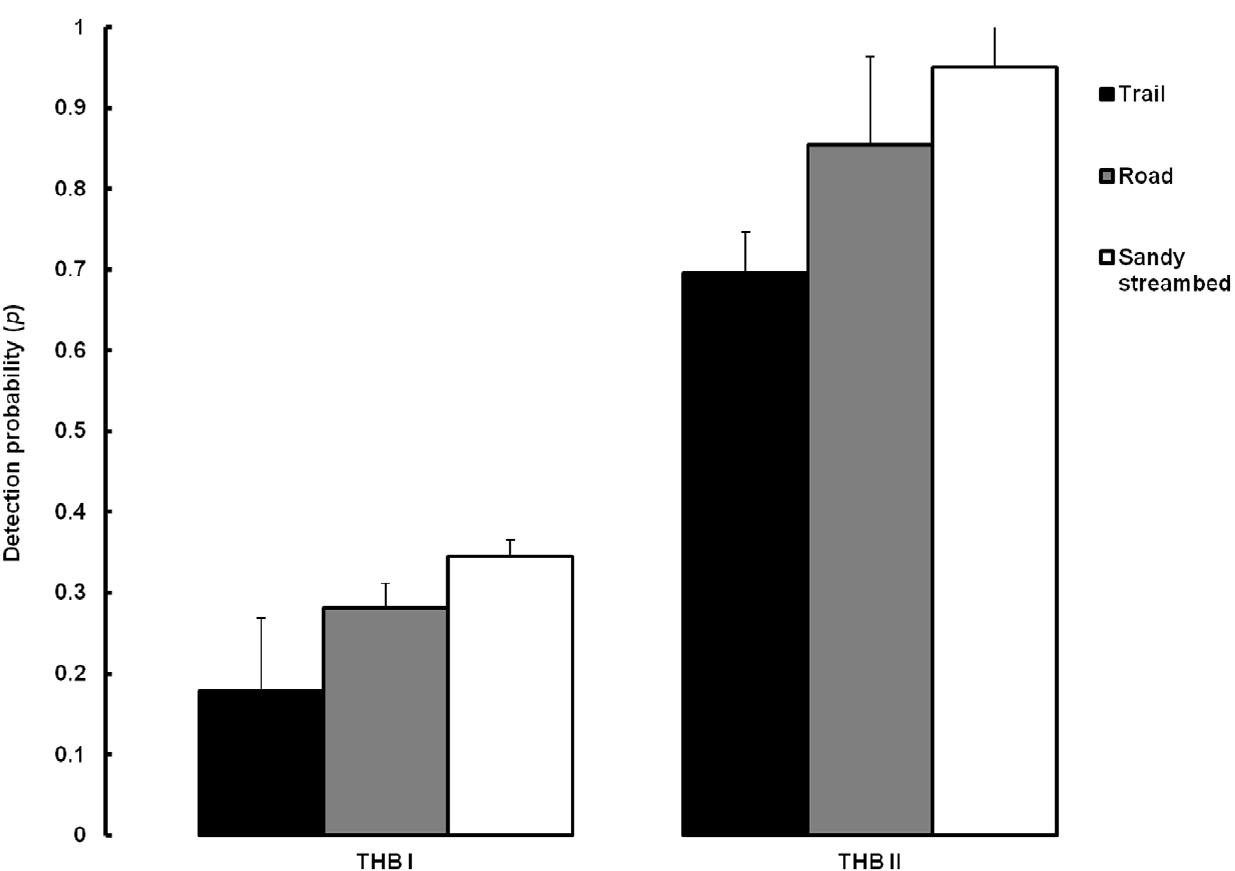
Figure 2. Probability of detecting tiger signs in THB I and THB II as a function of substrate type. Error bars represent one standard error.